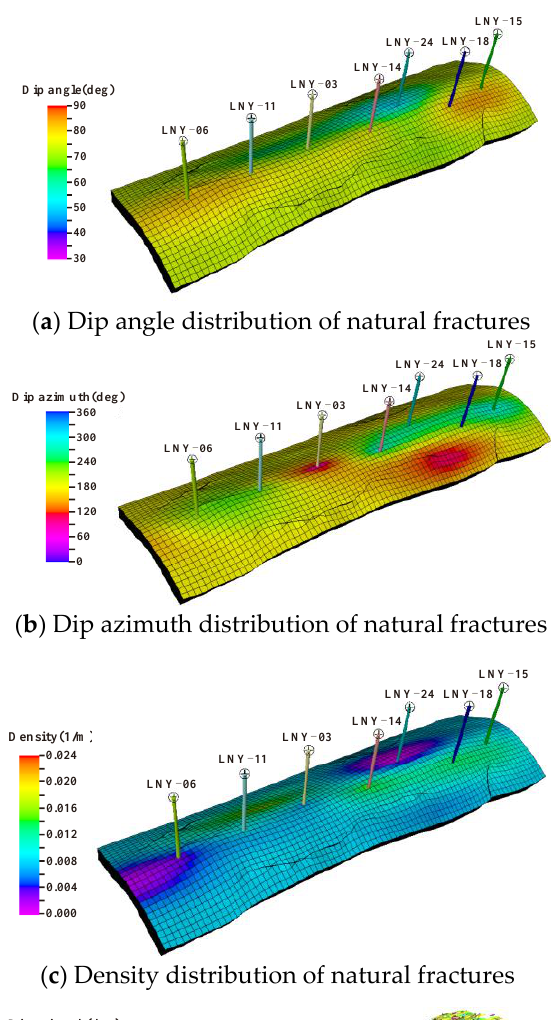
Figure 7. Schematic diagram of the distribution of faults.